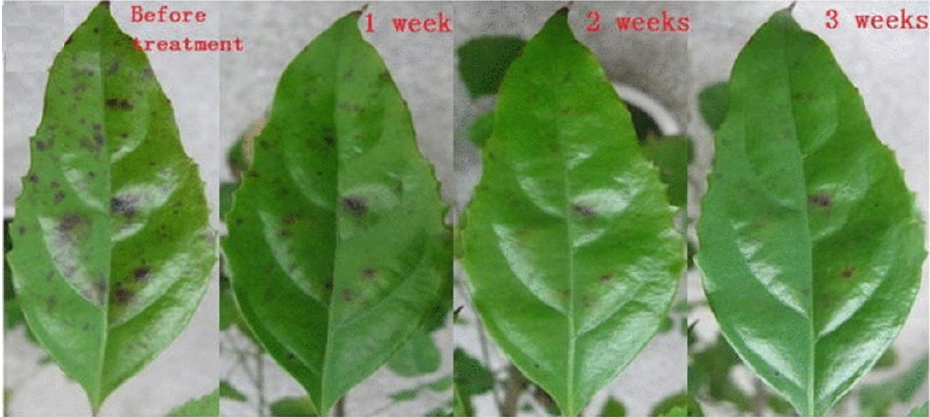
Figure 3. Plasma treatment drastically eliminated the initial symptoms of a fungus-infected leaf and advanced symptoms after 1–3 weeks plasma treatment [35]. Reprinted with permission from Ref.